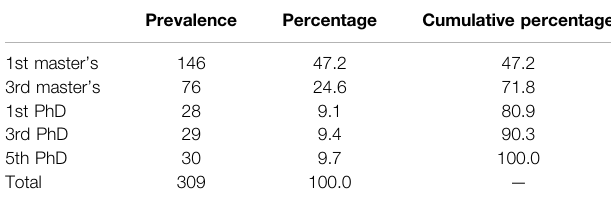
TABLE 1 | Number and percentage of students per cycle and current postgraduate